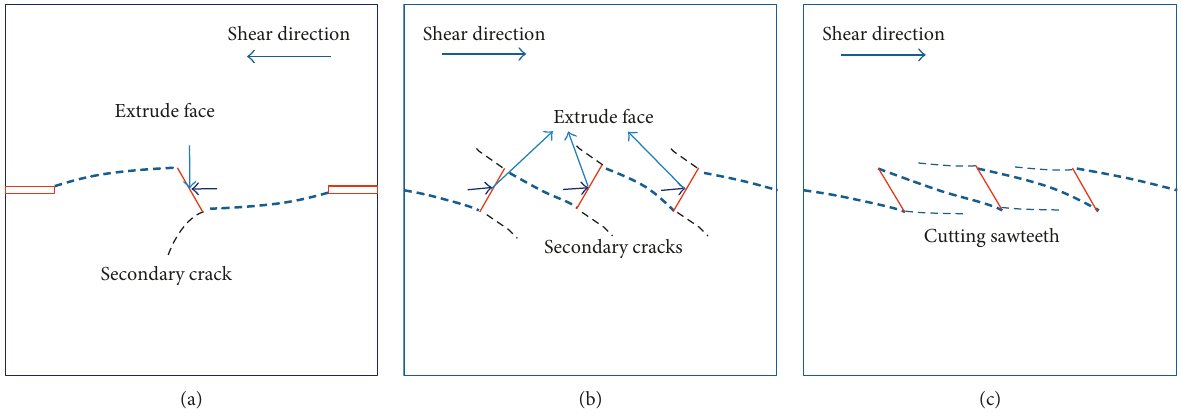
Figure 17: Schematic diagram of extrusion and sawtooth cutting.